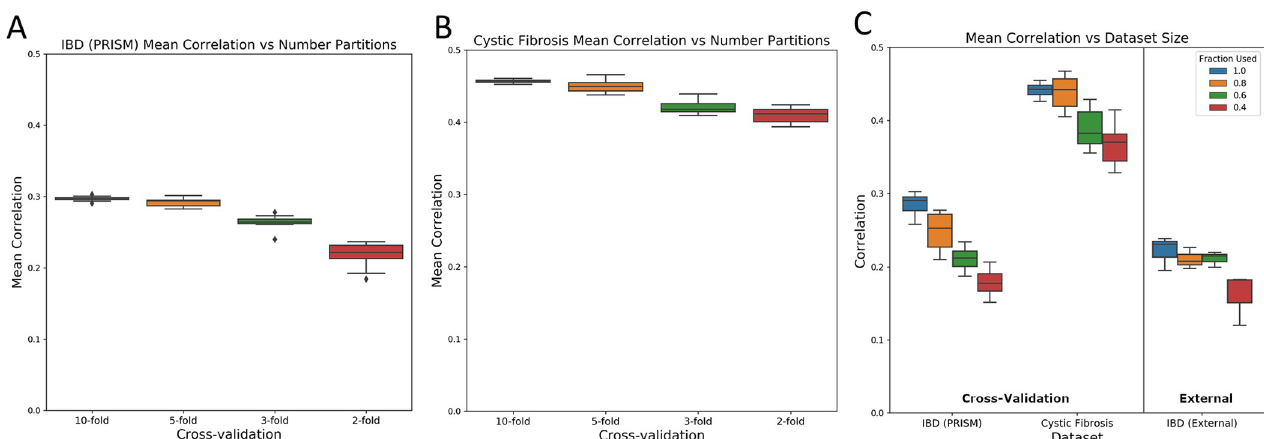
Fig 3. Mean correlation analysis using different amounts of training data. Correlations for 10-, 5-, 3-, and 2- fold cross-validation evaluations are shown for the (A) IBD (PRISM) and (B) cystic fibrosis datasets. (C) Subsets of the IBD (PRISM) and cystic fibrosis corresponding to 100%, 80%, 60%, and 40% of the total samples are used as an input for MiMeNet. Three random datasets for each level of subsetting were created and then mean correlation using 10 iterations of 10-fold cross-validation is calculated across the three. In addition, models trained on the complete subsets of the IBD (PRISM) data are used to evaluate the IBD (External) test